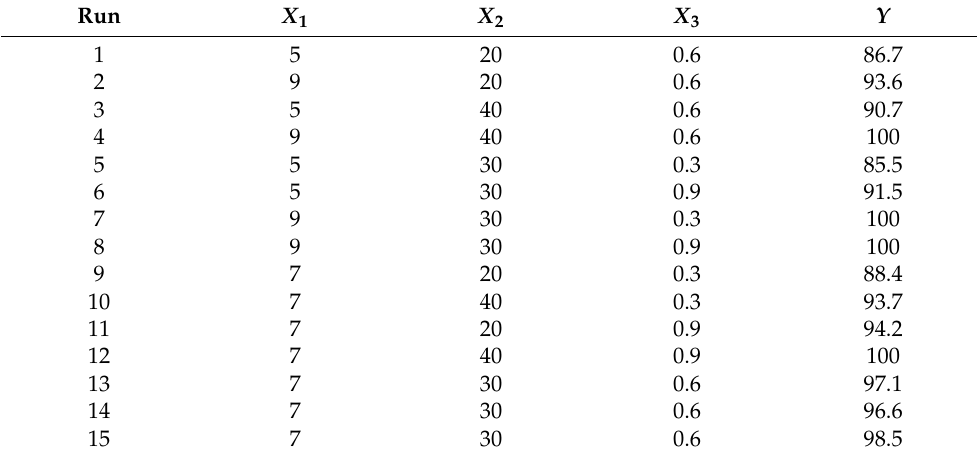
Table 1. Box–Behnken random design matrix and dependent variable response to tetramethrin degradation. Run X 1 X